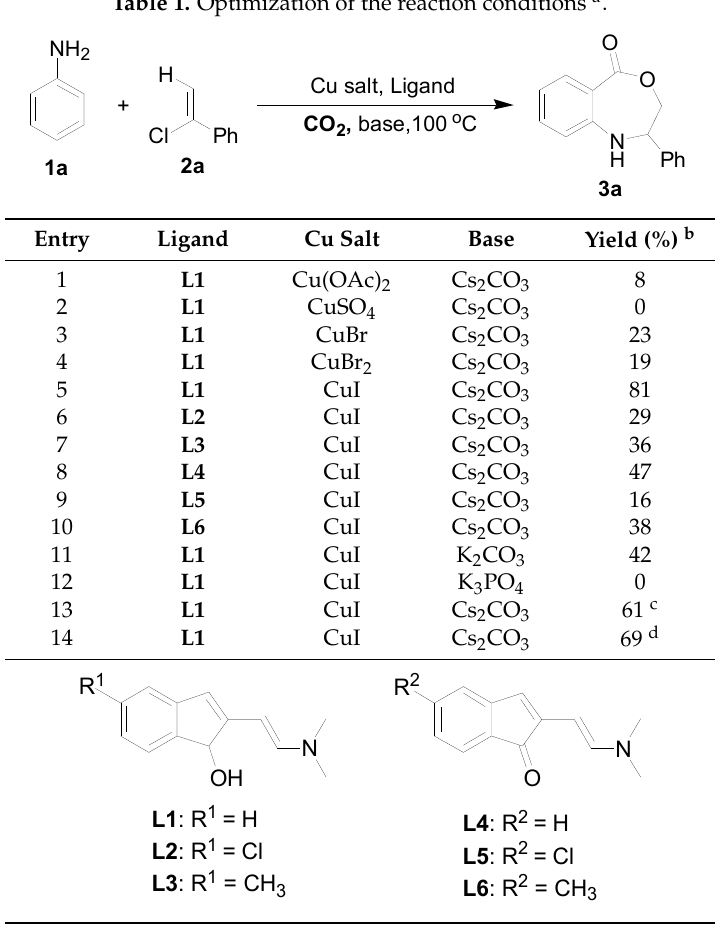
Table 1. Optimization of the reaction conditions a .